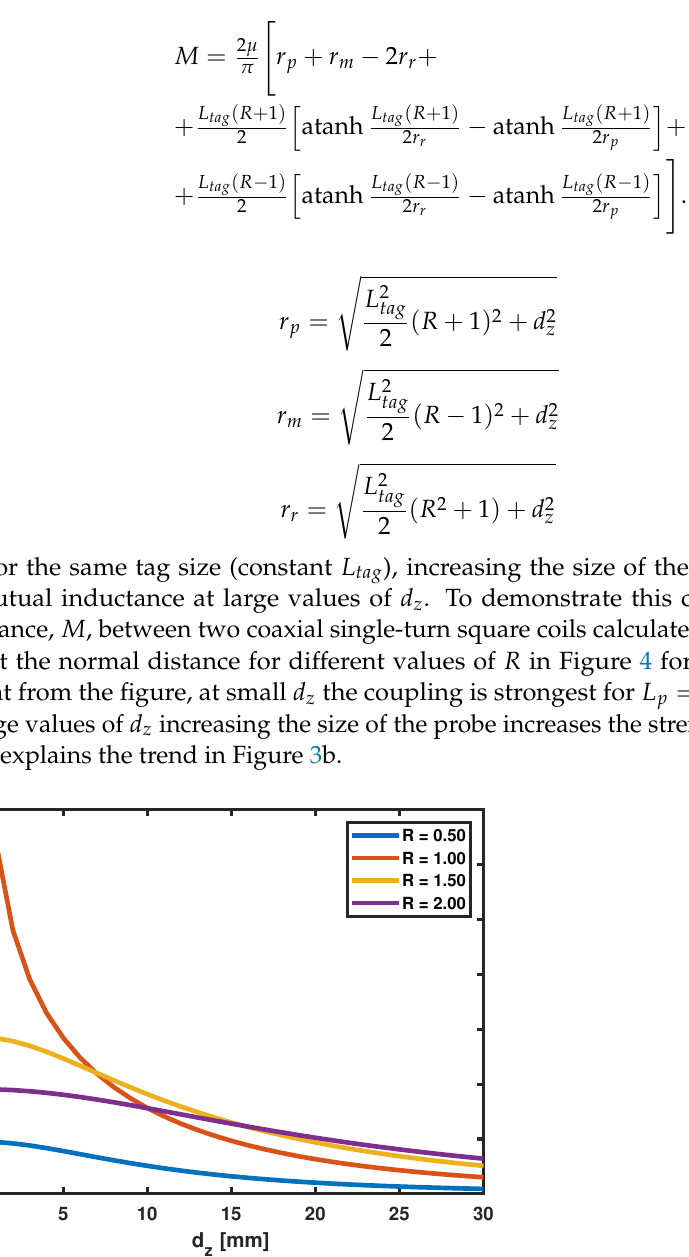
Figure 4. Mutual inductance between two coaxial single-turn square-shaped filament coils against the normal distance between them, d z , for values of r for a constant value of L tag = 30 mm, w = s = 2 mm. It is concluded that for applications where the size of the SR is a constraint, the sensing range (sensitivity at large normal distances) can be maximized by increasing the size of the probe compared to the size of the tag. The opposite is true for a scenario with restrictions on the size of the probe; in this case, the size of the SR must be decreased to increase the sensing range, whereas for applications requiring high sensitivity at small normal distances, the probing loop must be designed to have a side length close to that of the tag, which is consistent with previous works in the literature regarding the coupling coefficient optimization in wireless power transfer